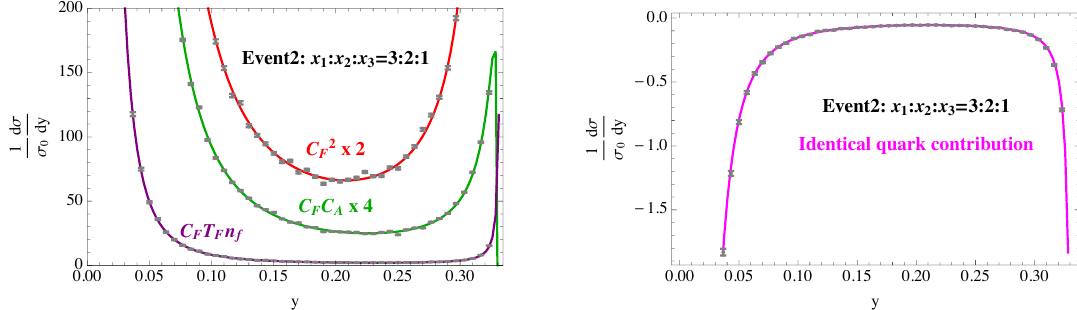
Figure 4 . Left: comparison of the analytic result with Event2 for separate color structures with and C are multiplied by a constant for clarity. Right: the { x 1 , x 2 , x 3 } = { 3 y, 2 y, y } . The C 2 F C A F identical quark part is verified separately since its contribution is